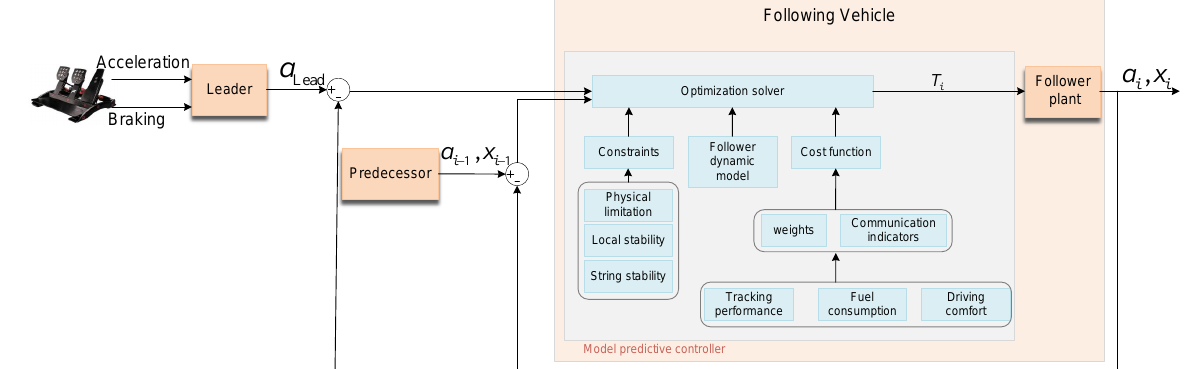
Figure 5. Control block